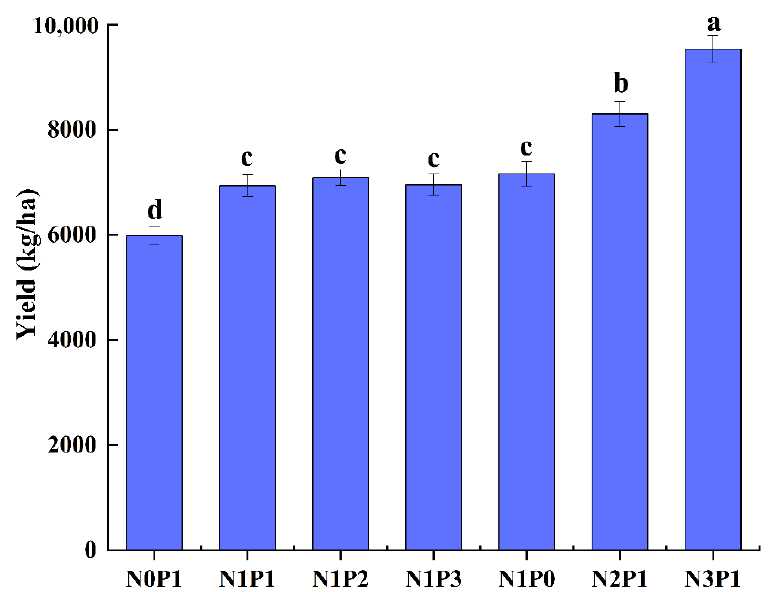
Figure 1. Effect of nitrogen and phosphorus regulation on yield of hybrid rice. The values represent the mean of three replicates. Different letters indicate a significant difference at p < 0.05.